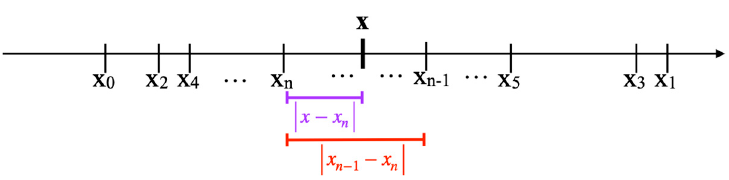
Figure 5. The distance between two succeeding convergents is greater than the distance of a conver- gent and the value of its continued